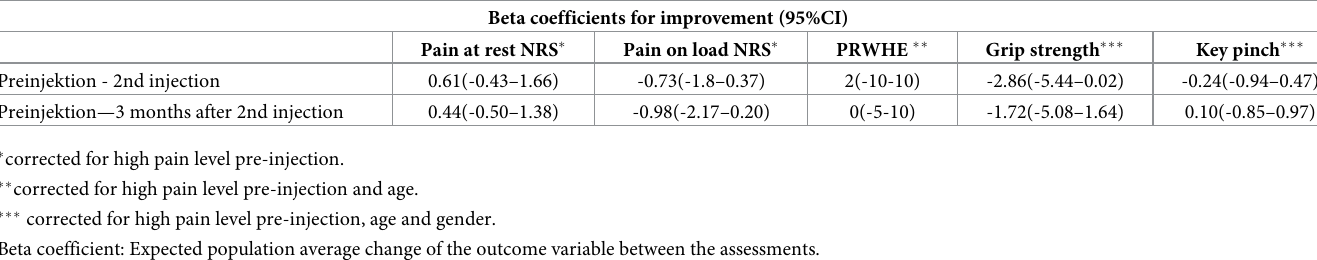
Table 3. Effect of PRP injection on pain, patient-rated result and